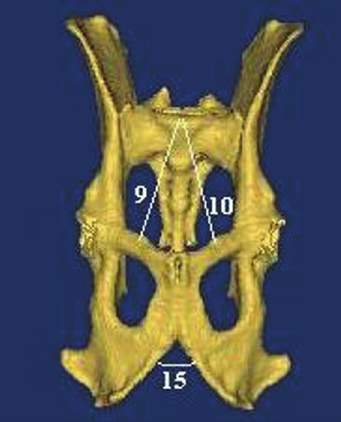
Figure 3: Measurements on facies ventralis of pelvic cavity.